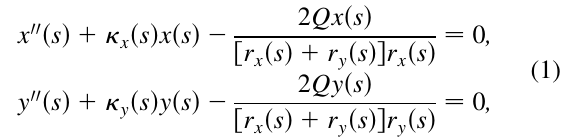
and r along the x and x y